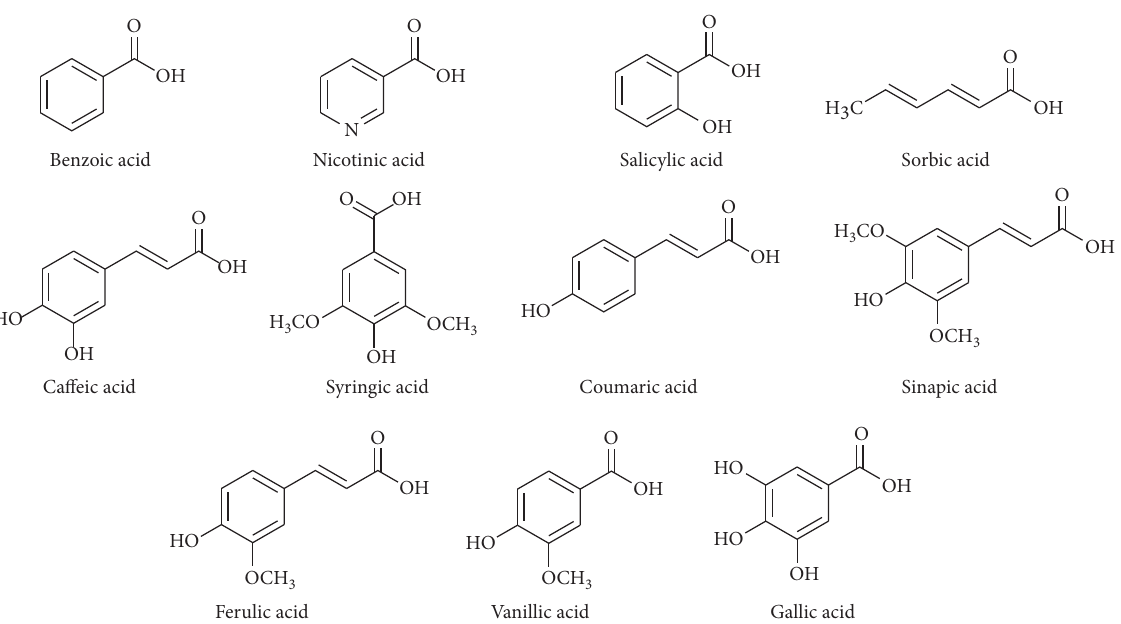
Figure 1: Chemical structures of phenolic acids and sorbic